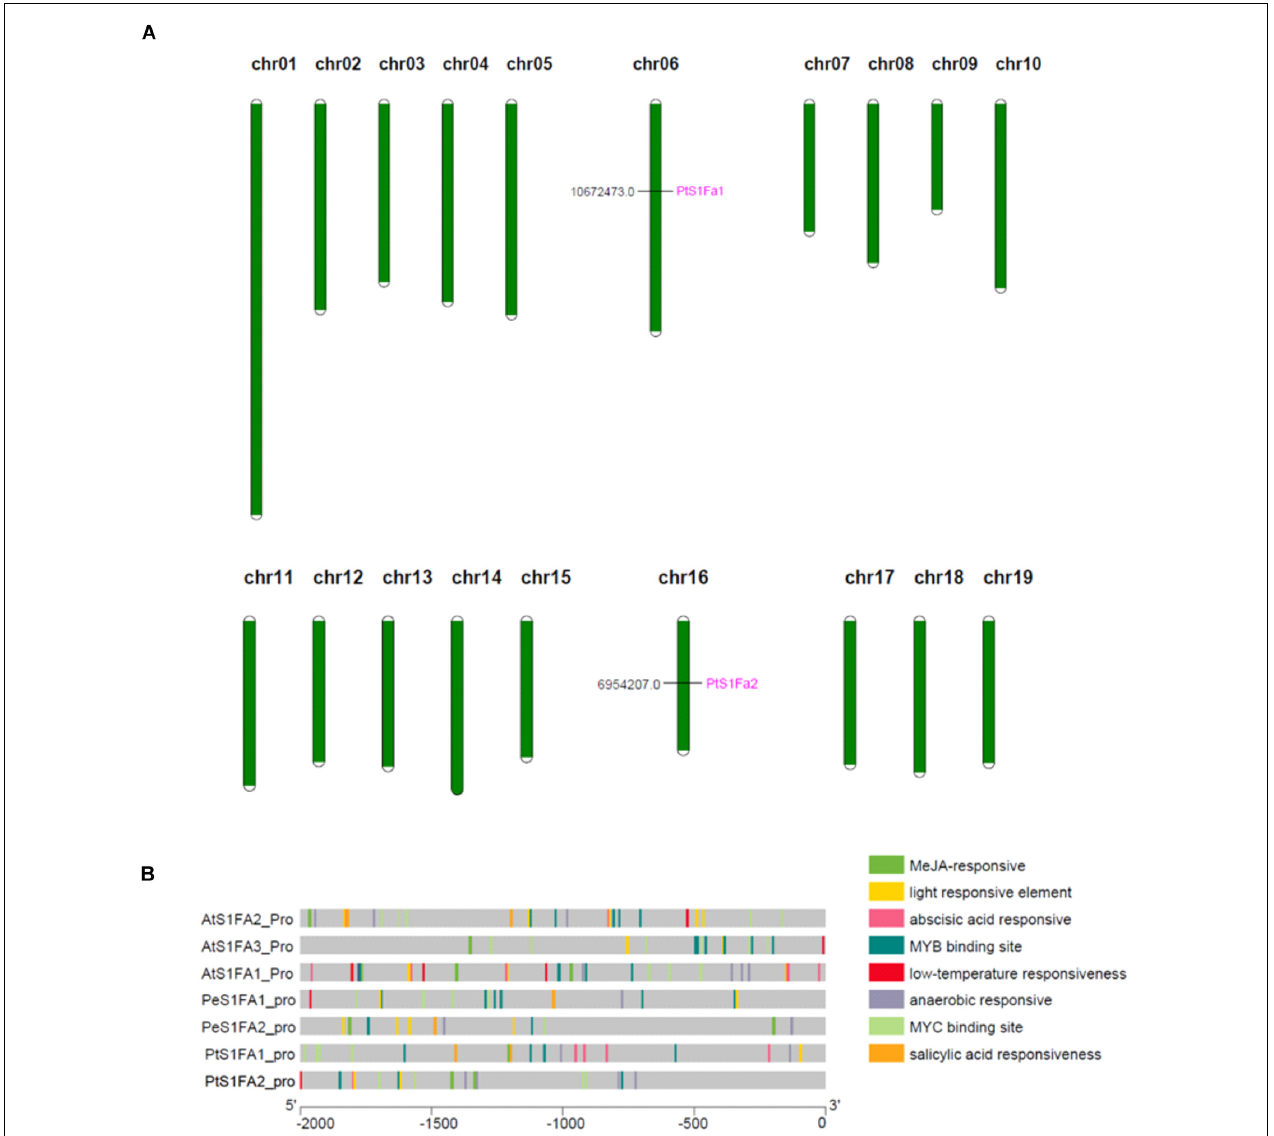
FIGURE 3 | Chromosomal localization of the S1Fa-like genes and gene duplication events. (A) The tandem duplication events and distribution of chromosome of poplar S1Fa-like genes. Chr01–Chr19 indicated the number of chromosomes 01–19. (B) Prediction of the cis- elements in the S1Fa-like gene promoters. On the left are gene names according to the phylogenetic tree. Different patterned colors on the right represent different cis-